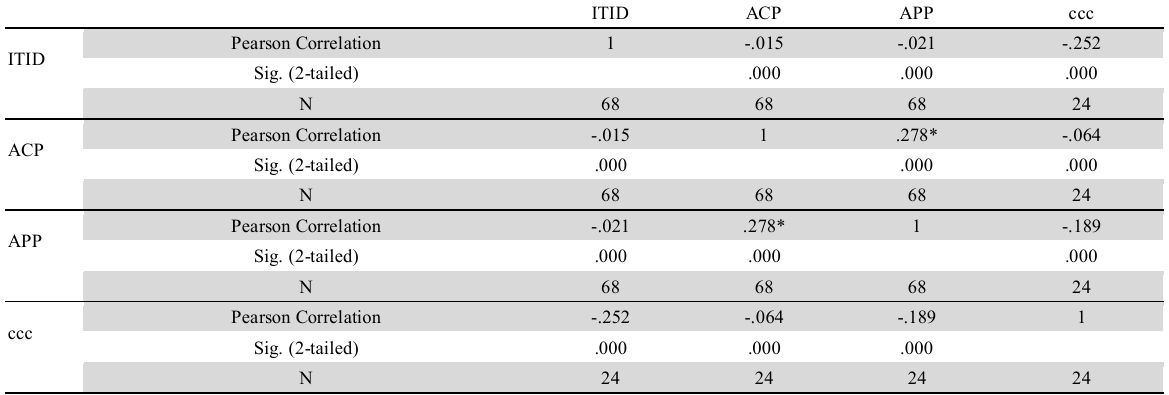
The linear independency analysis